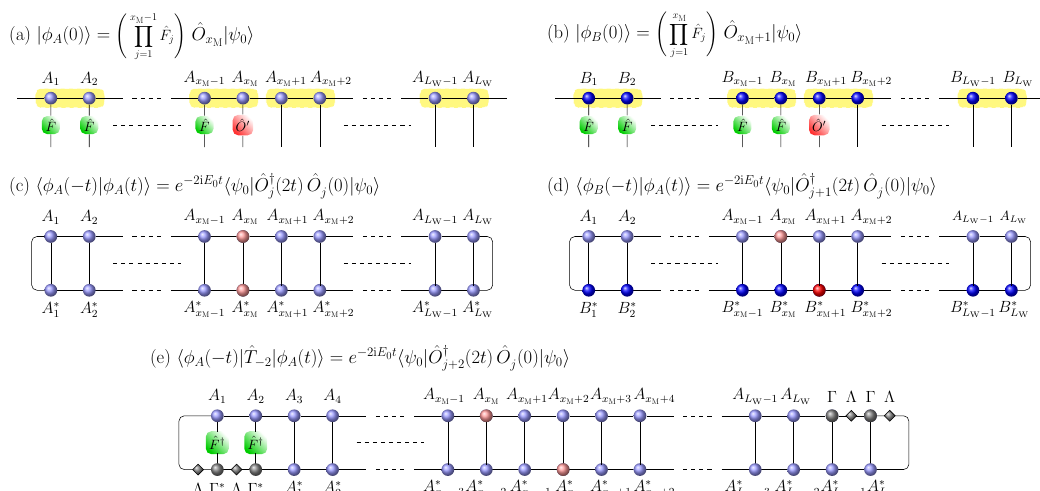
Figure 6: Graphical representation of the iMPS state for the calculation of dynamical correlation functions. The blue circles represent the tensors in the finite window, the squares correspond to the operators to be applied to the states, and the gray tensors in panel (e) represent the iMPS unit cell. Panel (e) shows how the correlation functions can be calculated for arbitrary distance by shifting the states relative to each other, i.e., by inserting an n -site translation operator ˆ T . For further explanation see text. n (cid:128)(cid:81) j − 1 (cid:138) = ˆ a = ˆ F ˆ O (cid:48) (ˆ O (cid:48) ˆ F ˆ a mapped operator , where ˆ O (cid:48) ). Note, that the Jordan-Wigner (cid:96) j , ↑ j j , ↓ (cid:96) = 1 j j j strings only act on the physical